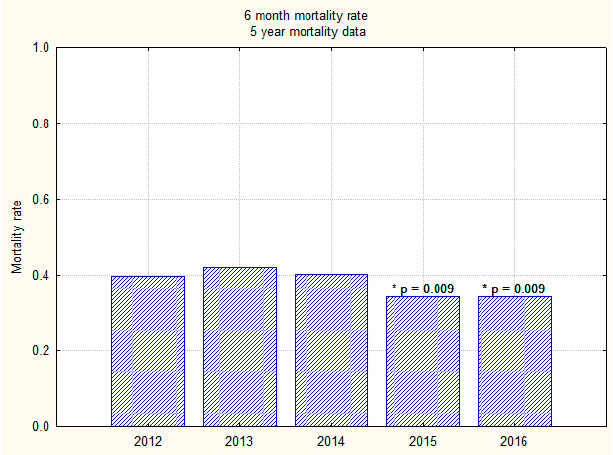
Figure 3. A bar graph showing 6-month mortality trend over 5 years (2012–2016). * A significant reduction ( p < 0.01).